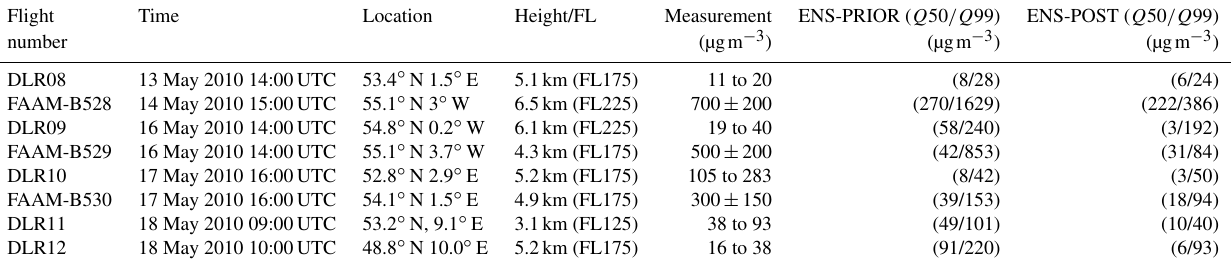
Table 2. Ash concentrations reported by DLR (Schumann et al., 2011) and FAAM (Marenco et al., 2011) flights and estimates from the ensemble outputs. The flight level (in brackets) indicates the mid-level of the ensemble output layers closest to the actual flight track heights (from FL25 to FL625 by 50). The concentration measurements are expressed as a range of values ( m min to m max ) for DLR flights or as mean value and uncertainty ( m mean ± σ ) for FAAM flights.